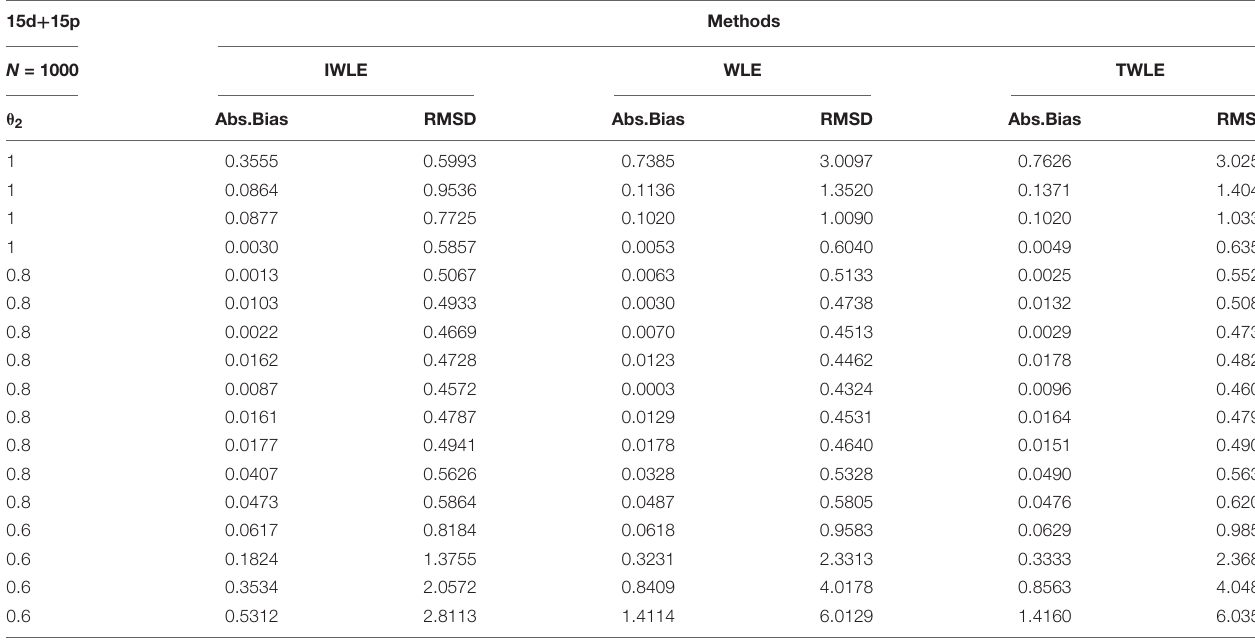
TABLE 5 | Absolute bias and root mean squared difference for WLE, TWLE, and IWLE at 3 different levels of growth on 15d +